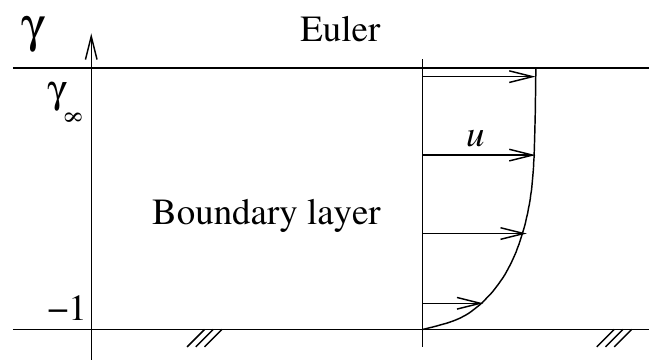
Figure 2. The sketch of the boundary layer